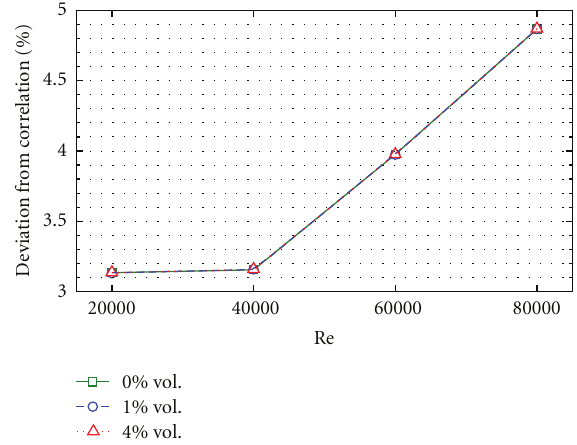
Figure 13: Performance of the Blasius correlation for pressure drop.